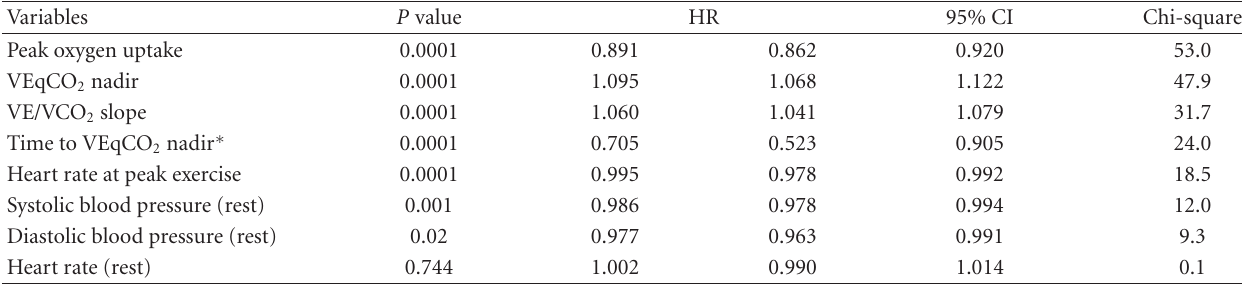
Table 2: Unadjusted univariable predictors of outcome (in order of Chi-square value).